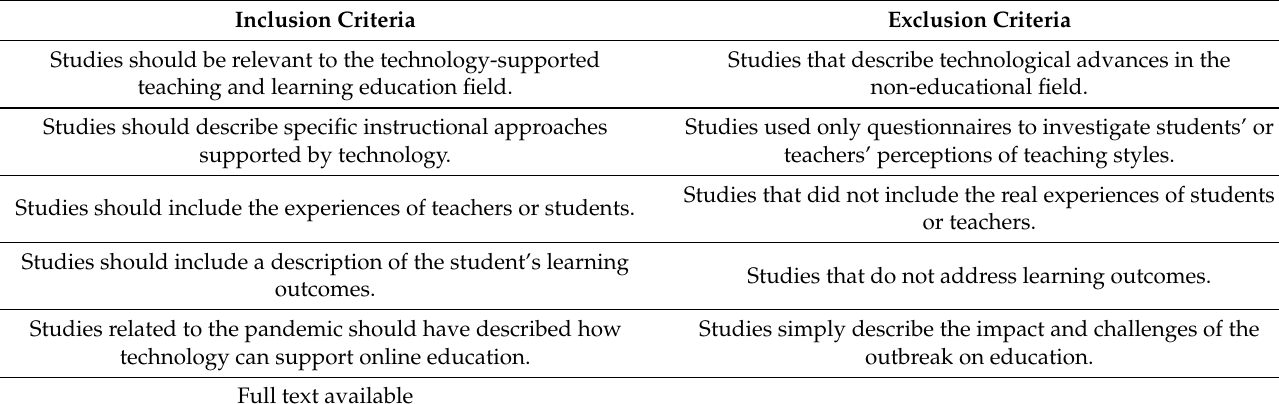
Table 3. Specific inclusion and exclusion criteria based on study aim and